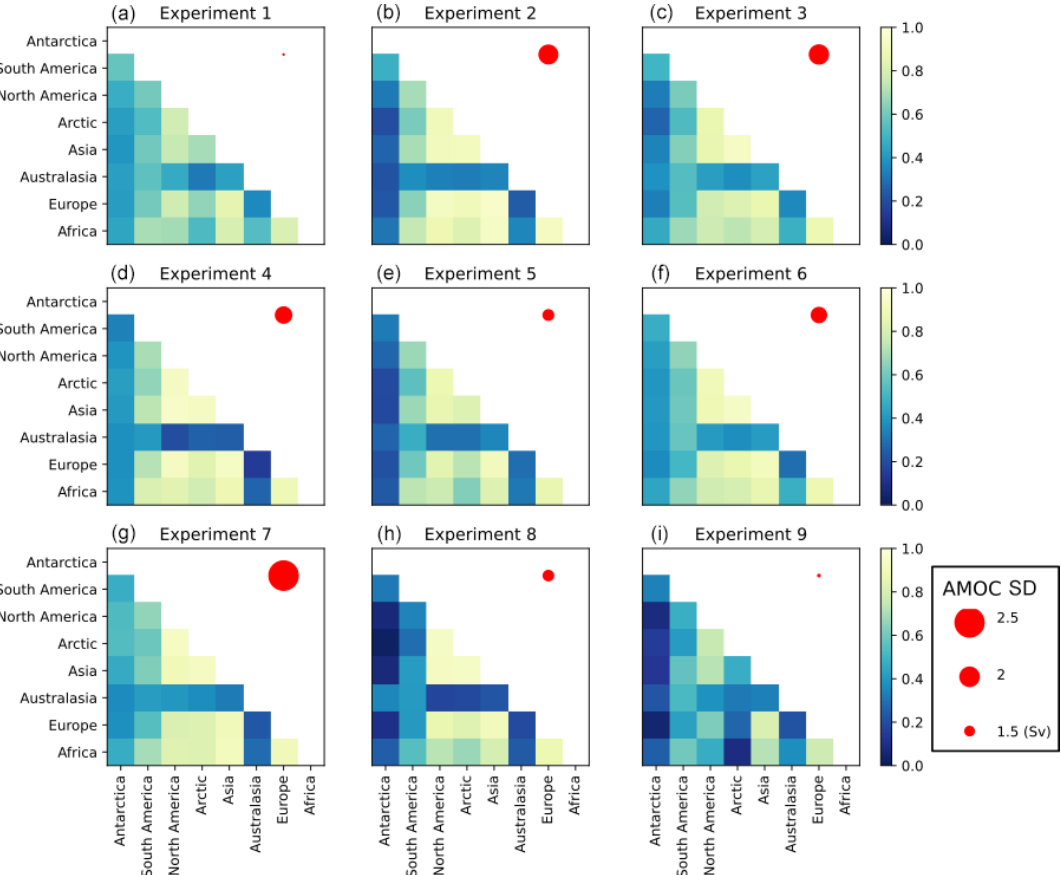
Figure A3. Inter-continental temperature correlations for all i LOVECLIM ensemble members. Panel (a) is the default simulation. Also indicated per experiment is the magnitude of AMOC variability (standard deviation in Sv) using the size of the red dot in the upper-right corner. In contrast to Fig. 5, the values shown here are non-lagged